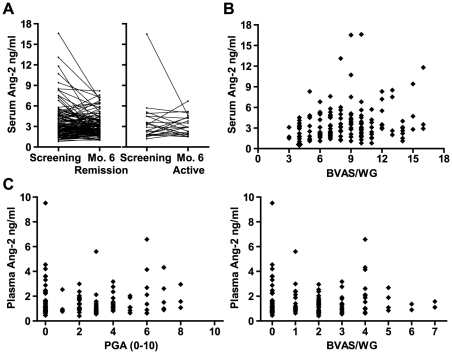
Angiopoietin-2 (Ang-2) levels at different levels of disease activity in ANCA-associated vasculitis.
A. Serum levels in individual patients in the RAVE trial before (Screening) and after (Month 6) treatment, stratified by whether patients were in remission (left panel) or had recurrent disease (right panel) at month 6. B. Plot of serum Ang-2 versus BVAS/WG score in individual subjects in RAVE at screening. Each patient had severe disease and therefore a BVAS/WG score of at least 3. C. Plot of plasma Ang-2 versus two measures of disease activity in the VCRC longitudinal study: Physician Global Assessment (PGA, left panel) and BVAS/WG score (right panel). Note that patients in remission (PGA = 0 and BVAS/WG = 0) are included, and that Ang-2 levels are lower in plasma than in serum.